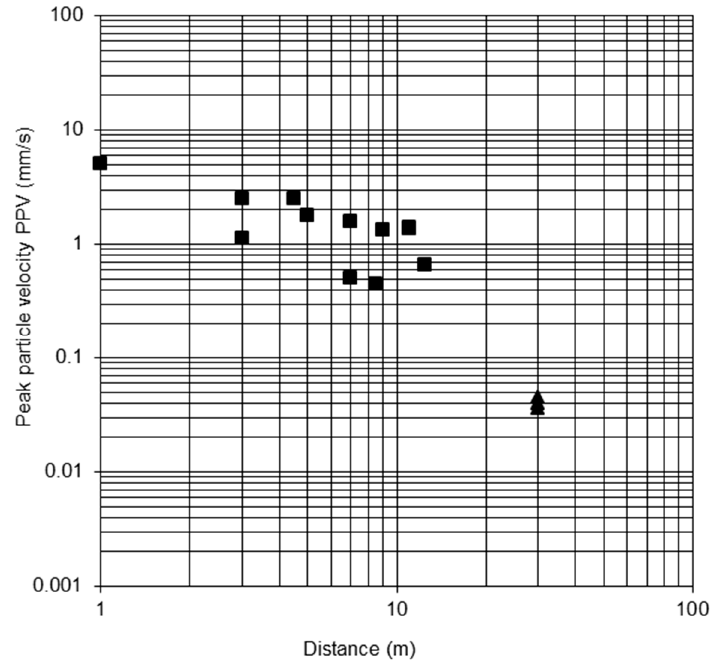
Figure 6. Logarithmic graph of the bulldozer.